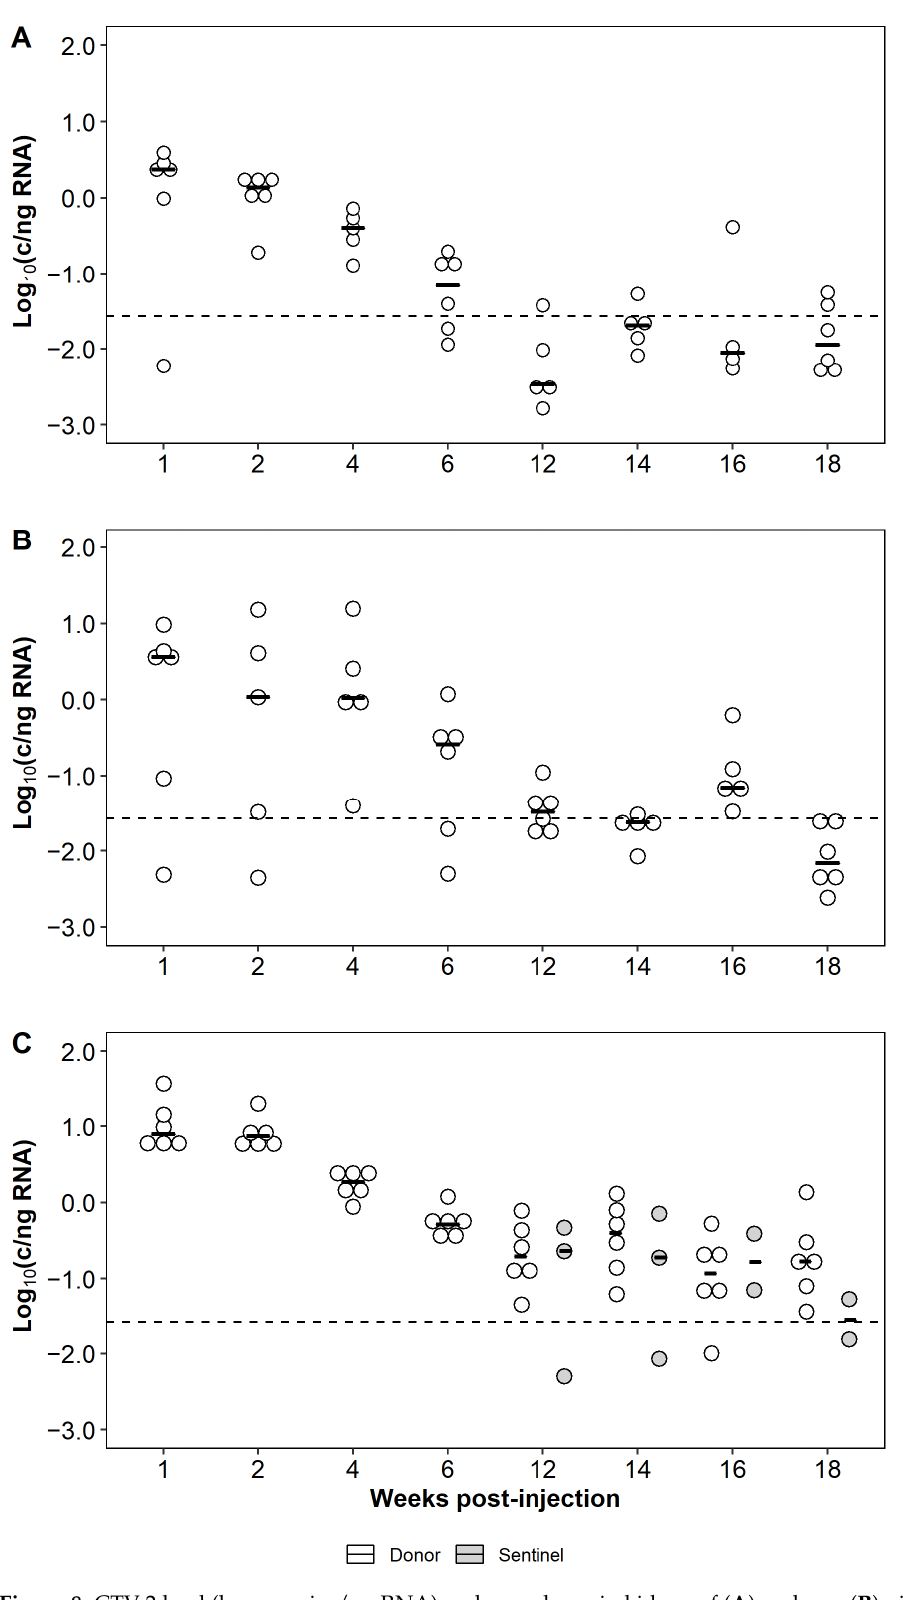
Figure 8. CTV-2 load (log 10 copies/ng RNA) and prevalence in kidney of ( A ) sockeye, ( B ) pink, and ( C ) chinook salmon in the conspecific cohabitation trial. Six fish were sampled per treatment at each time point and each dot indicates a positive fish. Crossbars denote median viral load. The dashed line denotes the reliable limit of detection of the qPCR